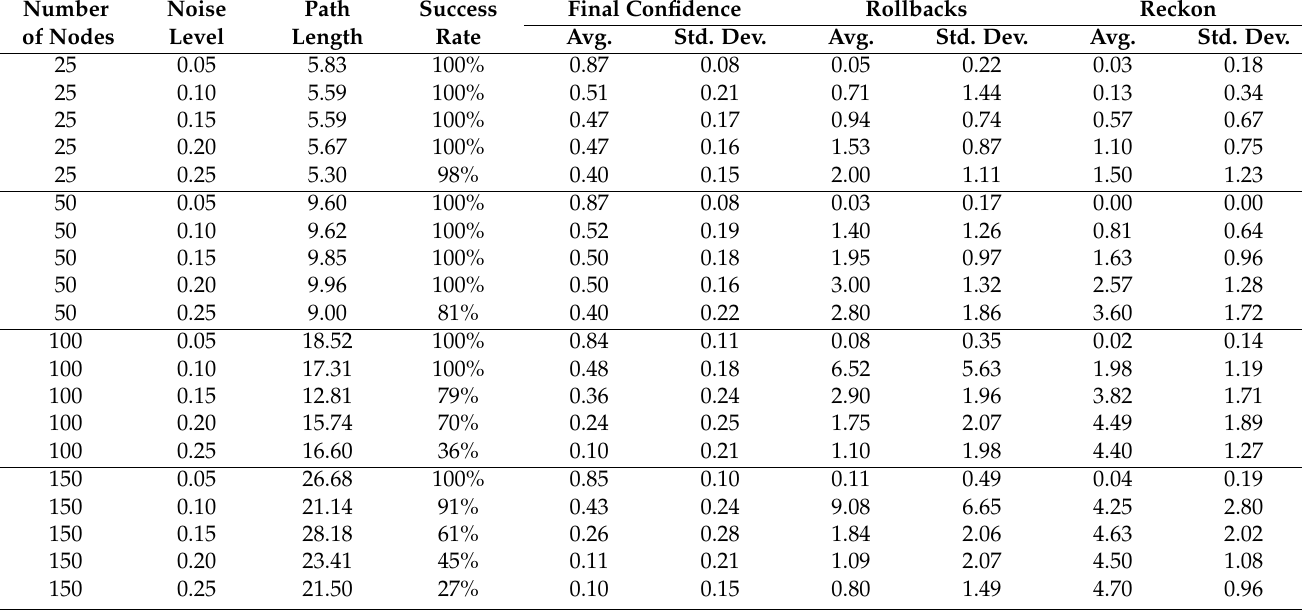
Table 2. Results of the path navigation and reckoning procedure.